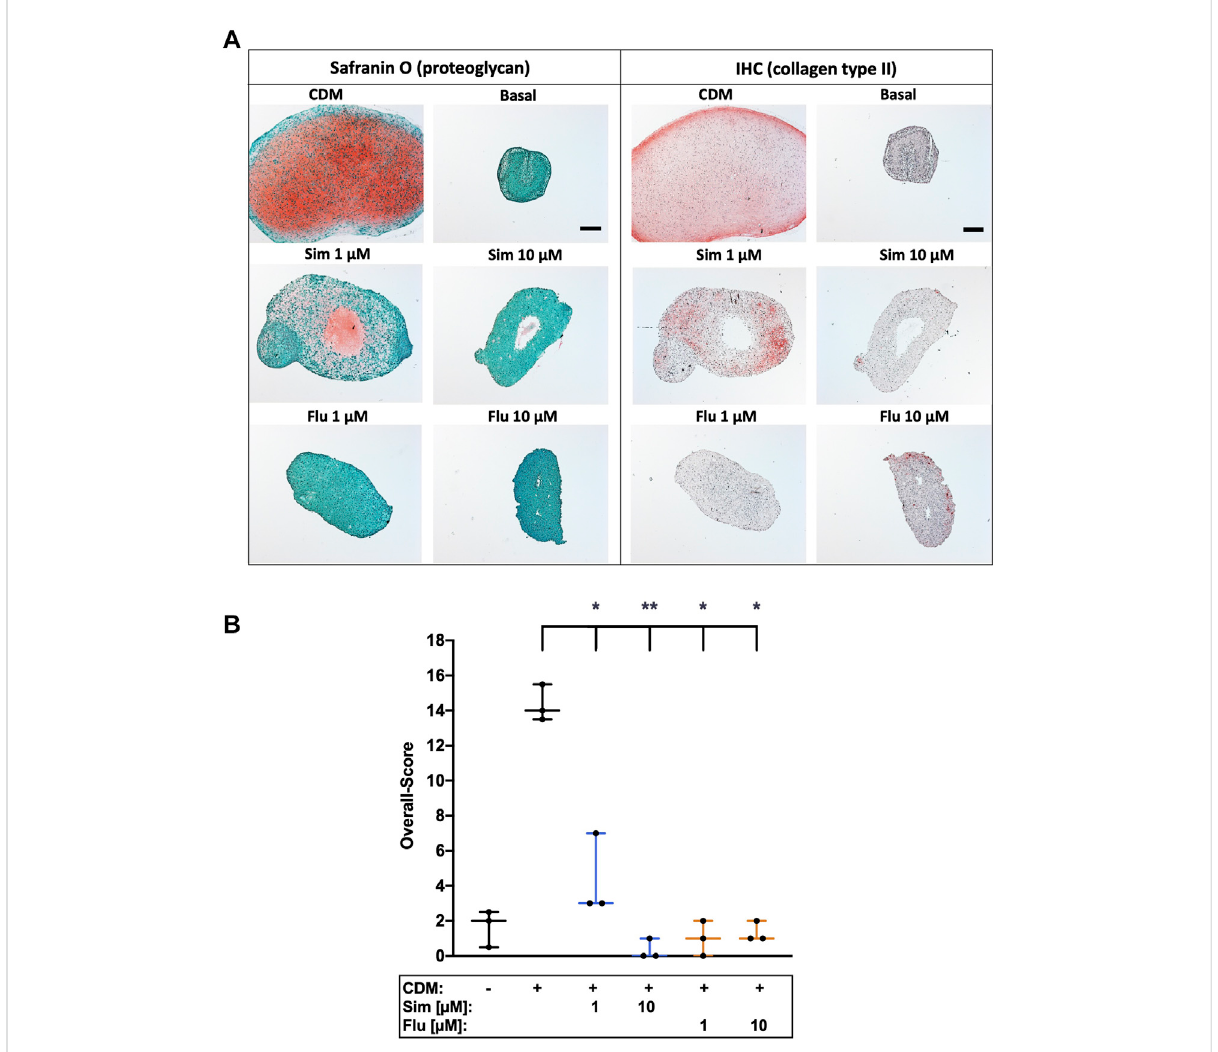
FIGURE 6 Effects of long-term statin treatment on chondrogenic differentiation of isolated chondrocytes (A) Chondrogenic redifferentiation of high passage chondrocytes was determined by means of proteoglycan (Safranin O) staining and collagen type II (IHC), as exemplarily demonstrated (B) Neocartilageformationwasfurtherassessedusingade fi nedscoringsystem.Blackscalebar=200 μ m;Signi fi cantdifferencesbetweengroupswere depicted as [versus CDM] * = p < 0.05; ** = p < 0.01; n =